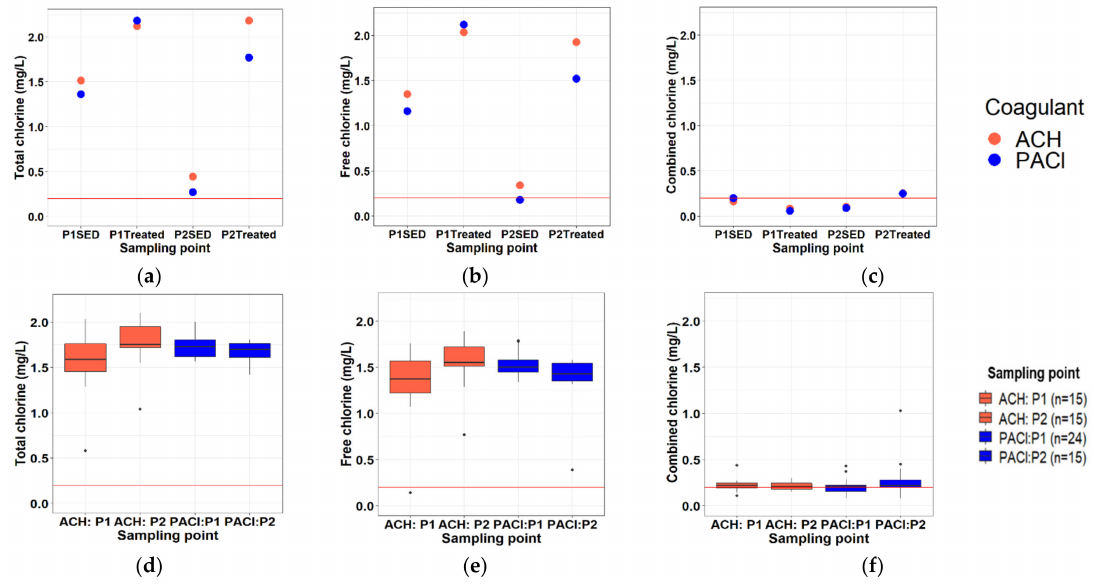
Figure 4. ( a ) Total chlorine in N-WTP, ( b ) free chlorine in N-WTP, ( c ) combined chlorine in N-WTP, ( d ) total chlorine in N-OKP, ( e ) free chlorine in N-OKP, ( f ) combined chlorine in N-OKP. Note: P1 denotes Phase 1 and P2 denotes Phase 2. The red lines indicate the guideline